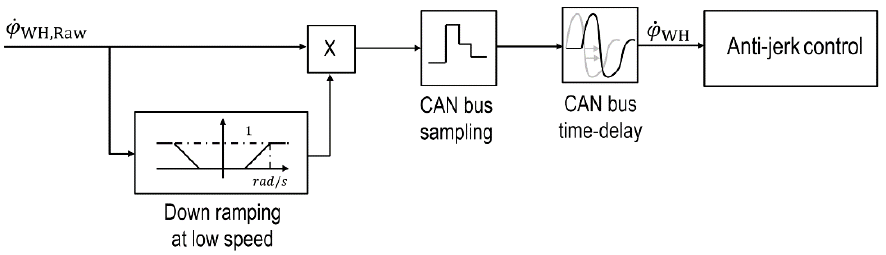
Figure 8. Emulation of a CAN bus network for the signal of the angular velocity of the vehicle wheel hub. wheel